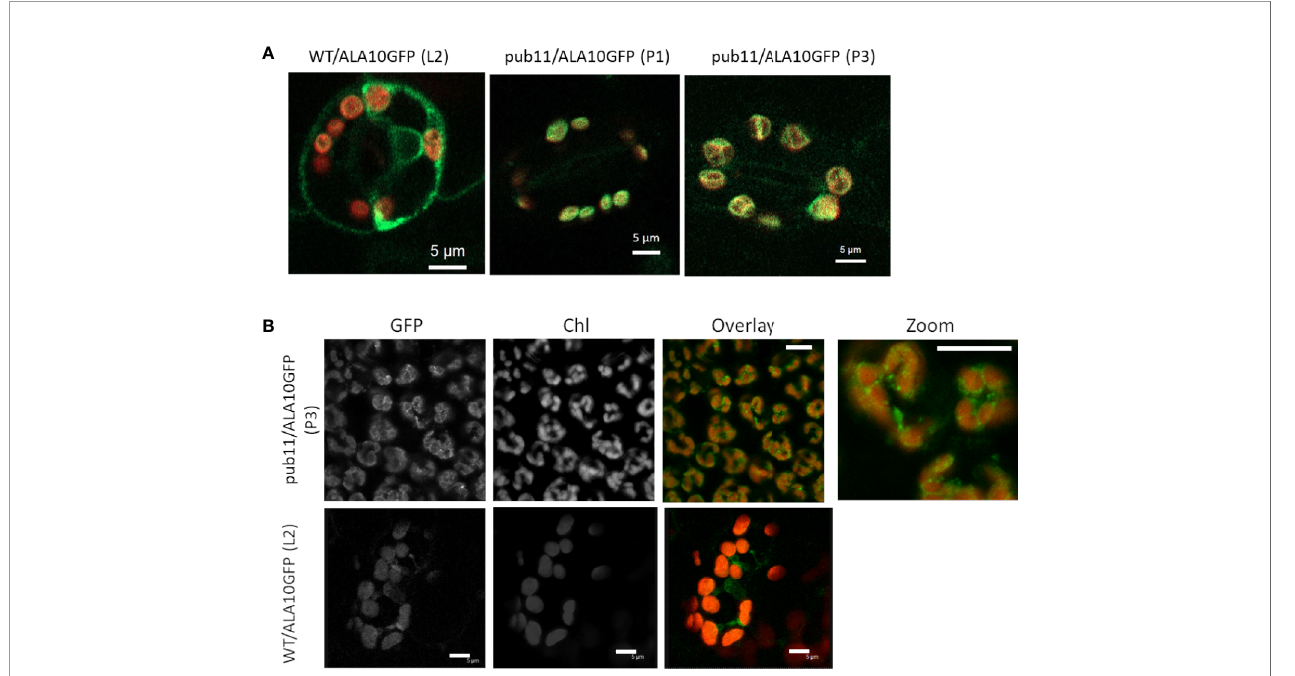
FIGURE 4 | Localization of ALA10 in the pub11 mutant by confocal microscopy. (A) and (B) Confocal imaging in WT or in pub11 background with stable expression of ALA10-GFP in guard cells (A) and in mesophyll cells (B) . In (A) overlay of the signals in the GFP (green) and chlorophyll (red) windows. Observation in two different lines compared with WT. In (B) , observation in mesophyll cells of a line of pub11 with stable expression of ALA10-GFP. Scale 5